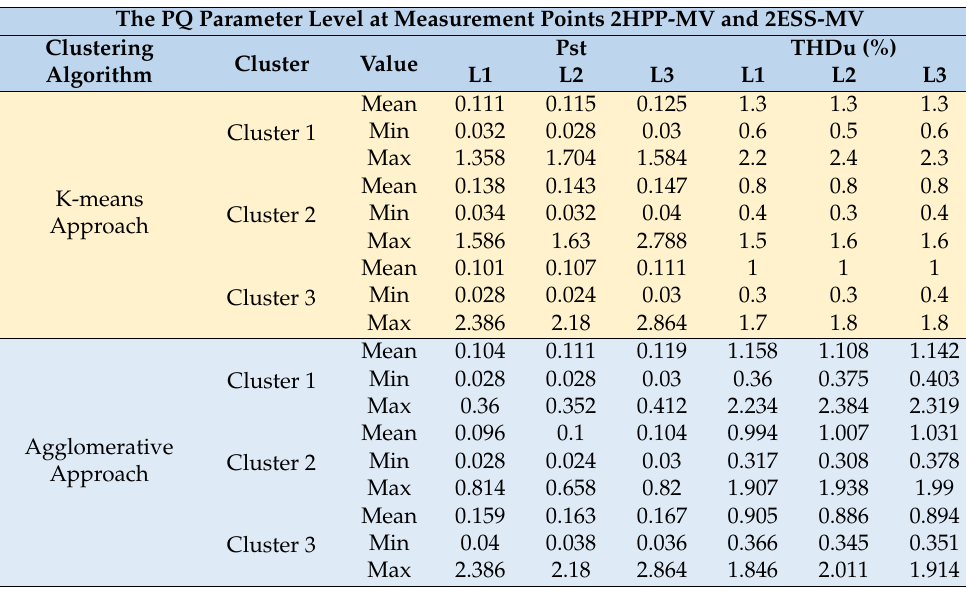
The level of PQ parameters by the K-means algorithm approach. Cluster “2” represents the average of short-term flicker severity (Pst) in each phase at a higher level than the other clusters, while cluster “1” represents the highest average value of THDu in each phase compared to the other clusters. This can be seen clearly in Figure 6.